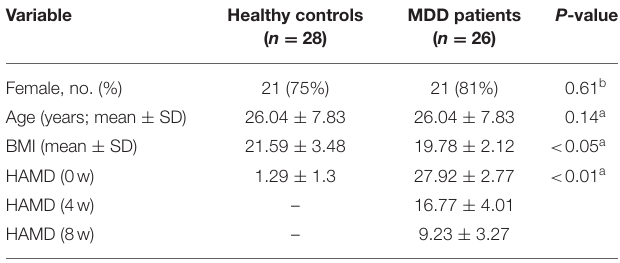
TABLE 1 | Patient